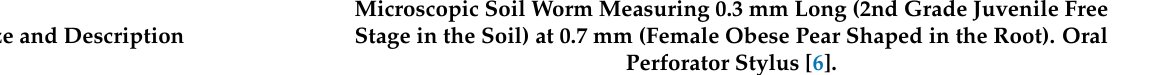
Table 1. General characteristics of Meloidogyne